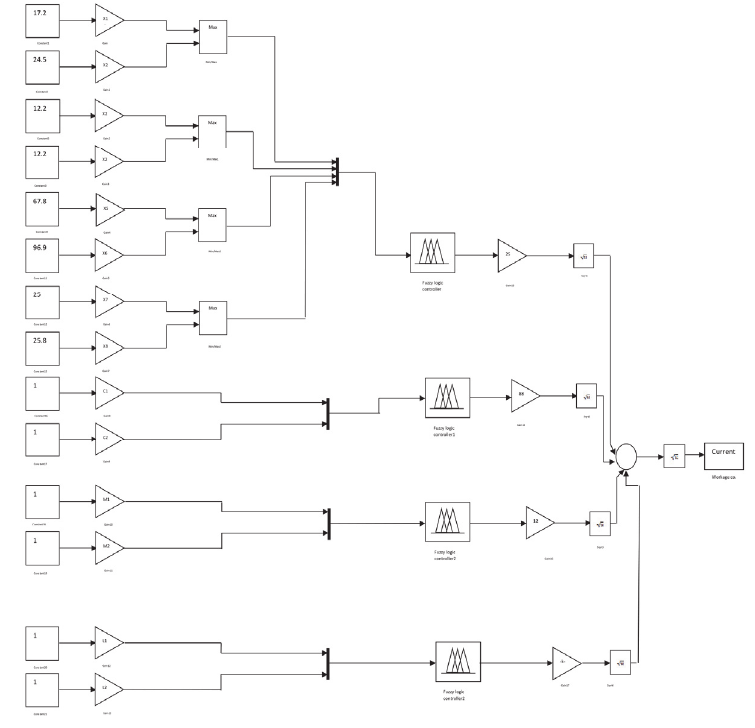
Fig. 2. System Modeling in